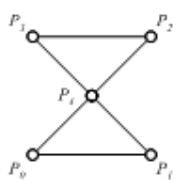
Figure 6: Closeness error of LinearRing feature